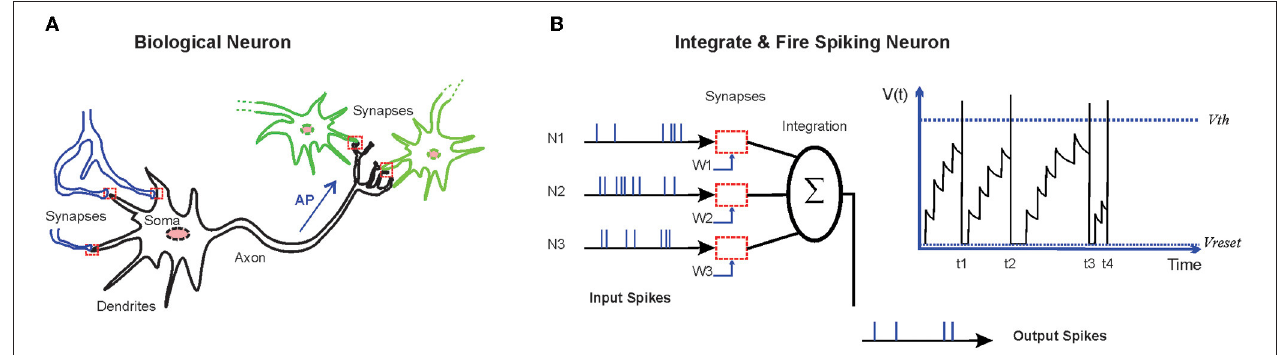
FIGURE 1 | (A) A schematic representation of biological neurons. Biological neurons are connected to some other neurons through synapses, where signals are transmitted in the form of released neurotransmitters from the terminal of the axon. The signals from the dendrites are joined in the soma. Action potential (AP), triggered at the soma, travels down the axon and ends at the terminal of the axon. The axon is the elongated fiber that extends from the soma. (B) Integrate and Fire neurons are dynamical models of the biological neurons. Incoming spikes push the state of the neuron [membrane potential (V)] higher. The neuron fires at the moment of threshold ( V th ) crossing. After firing, the state variable is reset to its base value ( V reset